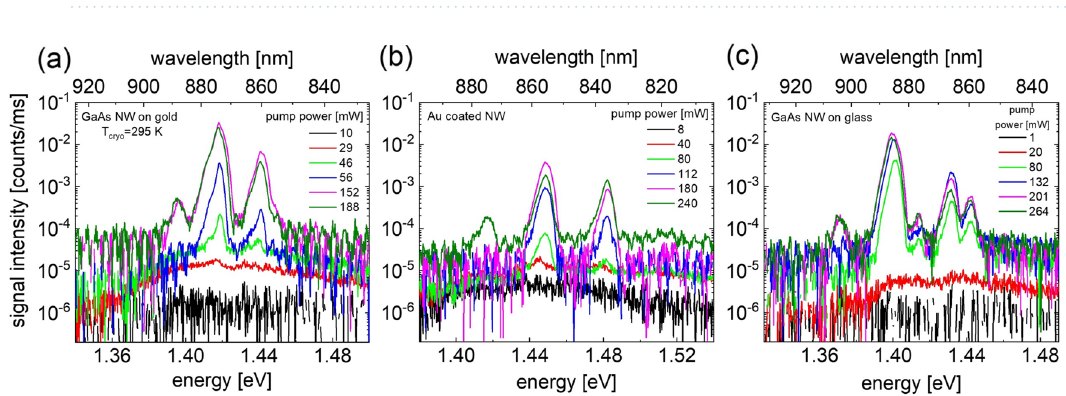
Figure 5. Temperature dependent laser emission spectra of ( a ) a GaAs NW on Au film at an excitation power of 120 mW and ( c ) an Au coated NW on glass substrate at a pump power of 140 mW. The redshift and weakening of the laser emission with increasing temperature is attributed to temperature-induced changes of the refractive index and the gap energy as well as a reduced material gain. The SEM images of the investigated NWs are shown in ( b , d ).